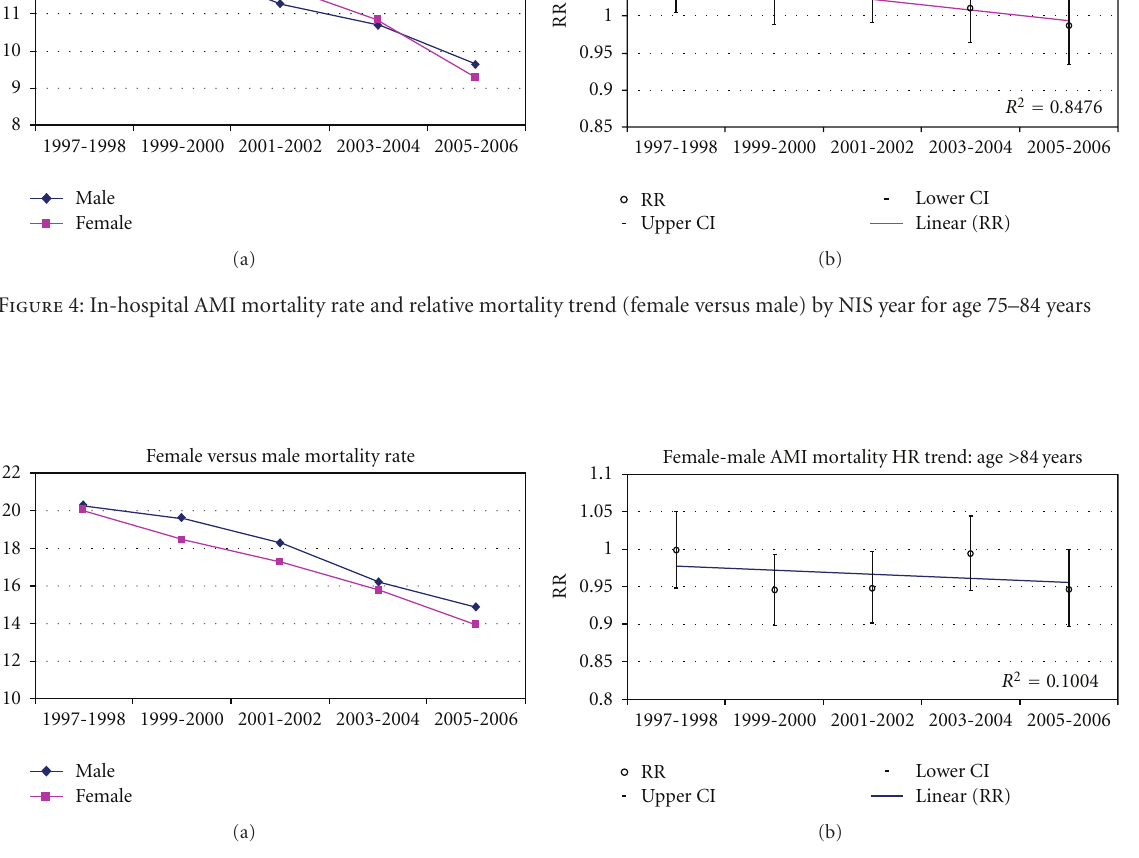
Figure 5: In-hospital AMI mortality rate and relative mortality trend (female versus male) by NIS year for age > 84